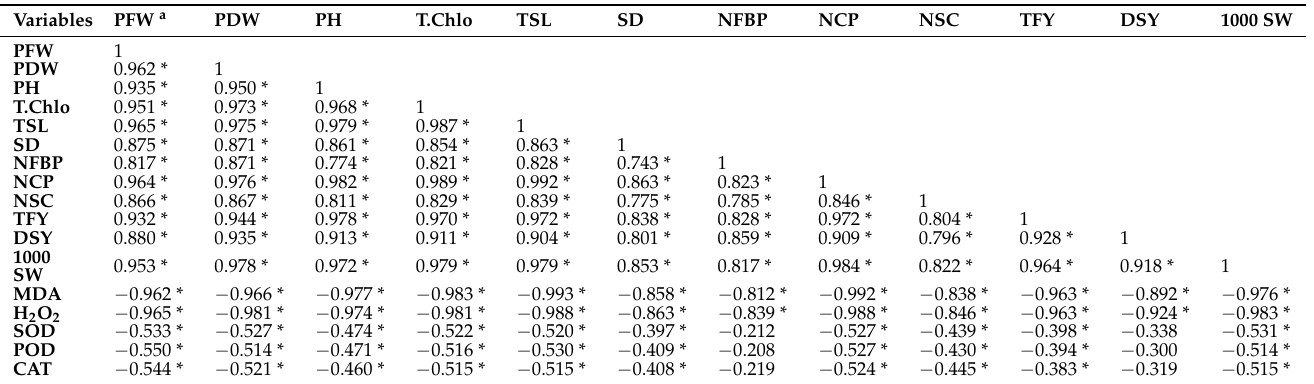
Table 5. Spearman correlation matrix for studied variables and biomass and yield attributes of flax plants raised from iron oxide NPs primed